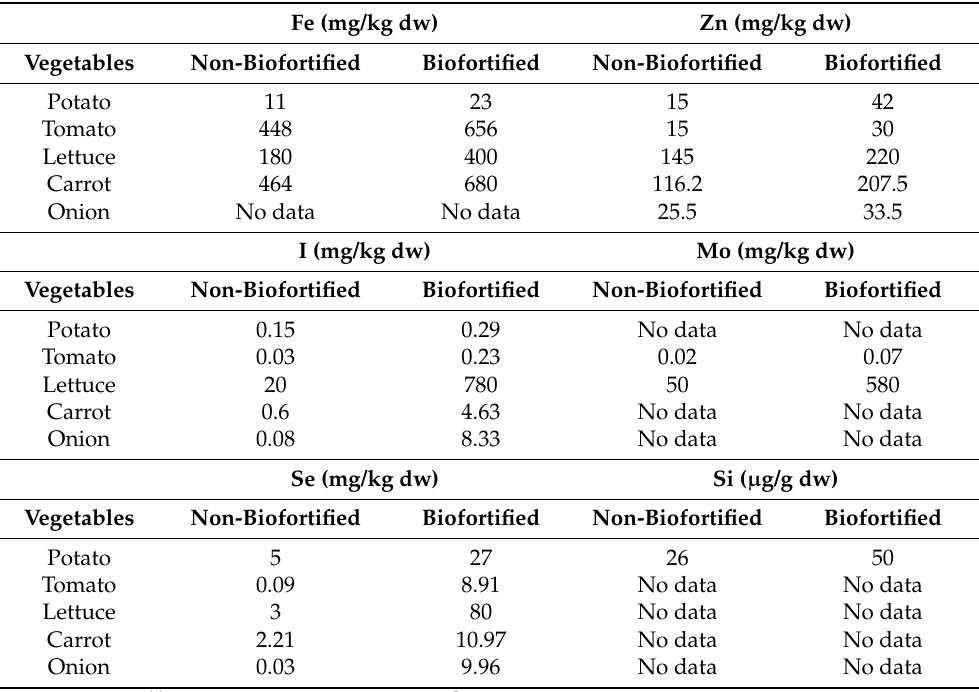
Table 2. Mean concentration of iron (Fe), zinc (Zn), molybdenum (Mo), selenium (Se), and silicon (Si) of the most consumed vegetables (potato, tomato, lettuce, carrot, and onion) pre- and post- biofortification (1)